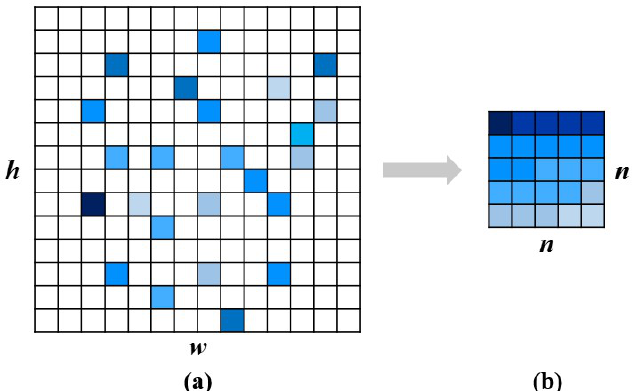
Figure 5. The process of obtaining an attentive map. ( a ) is the convolutional activation map with the highlighted top n × n responses, and ( b ) is the corresponding attentive map, where n is set to 5. Note that, the deeper the color, the larger the